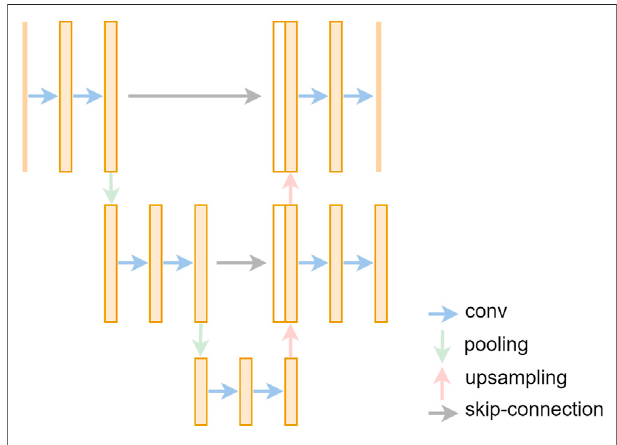
FIGURE 4 | The structure of U-net.